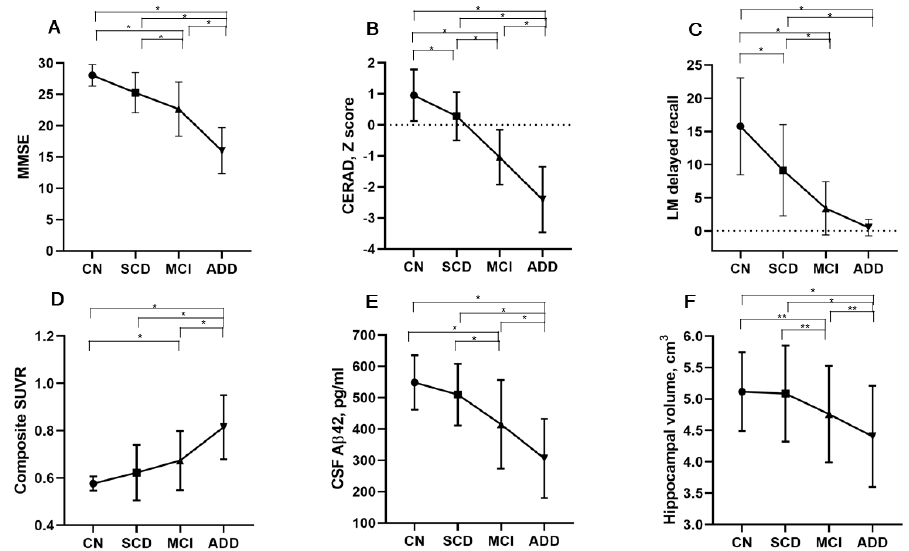
Figure 1. Mean (SD) of representative imaging and cognitive summary measures according to the Alzheimer’s disease (AD) clinical spectrum. In the Mini-Mental State Examination (MMSE) scores, CSF A β 42 level and hippocampal volume, there was a significant difference between all the groups, except between cognitively normal (CN) and subjective cognitive decline (SCD) groups ( A , E , and F ). The Consortium to Establish a Registry for AD (CERAD) Z scores were significantly different between all groups with better performance in the direction of CN group > SCD > mild cognitive impairment (MCI) > AD dementia (ADD) ( B ). Mean score of the logical memory (LM) delayed recall test differed between all groups, except between MCI and ADD groups ( C ). The composite standardized uptake value ratio (SUVR) of cortical flutemetamol retention was significantly different between all groups, except between CN and SCD and between SCD and MCI ( D ). * p < 0.01; ** p < 0.05. Table 4. Neuropsychological test results according to the AD clinical spectrum. Neuropsychological Test